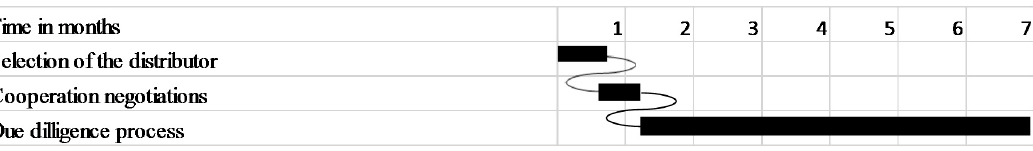
Figure 3. The selection process.